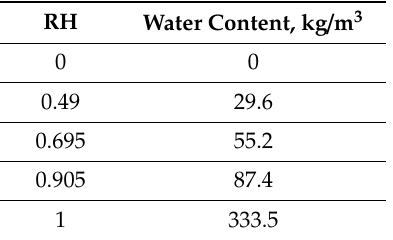
Table A17. Moisture storage function—Design.